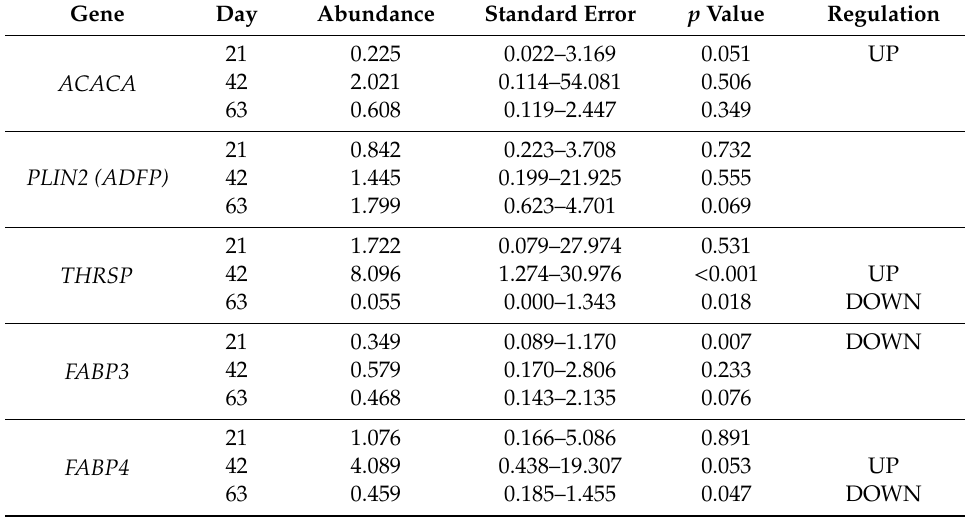
Table 5. Relative abundance of genes involved in lipid metabolism in milk somatic cells from cows fed hydrogenated vegetable oil (HVO) using the control (no fat supplementation) as the reference condition (control vs. HVO, in each sampling time). Gene Day Abundance Standard Error p Value Regulation 21 ACACA